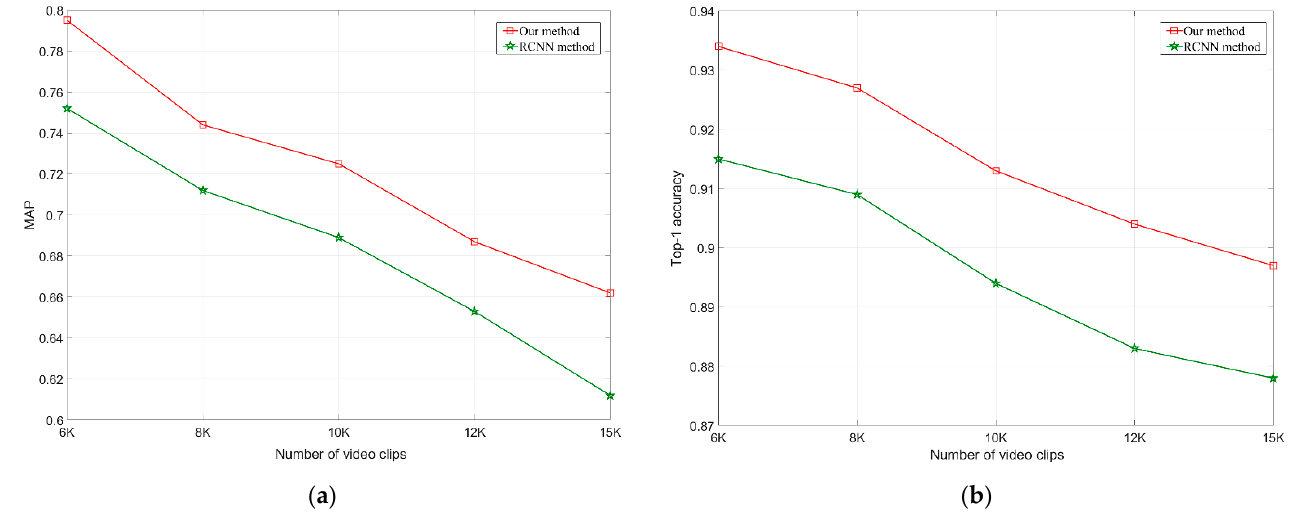
Figure 7. The accuracy comparison between our method and the RCNN method with different numbers of video clips: ( a ) MAP comparison; ( b ) Top-1 accuracy comparison.